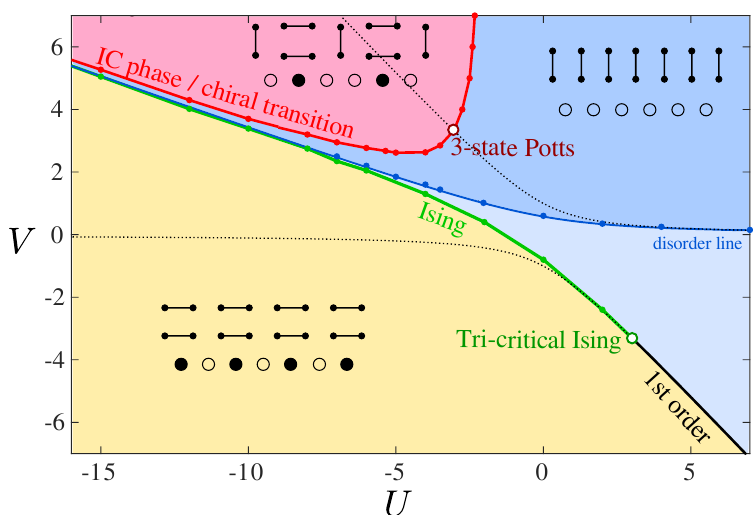
Figure 8: Combined phase diagram of the quantum dimer model defined by the Hamiltonian of Eq.10, and of the hard-boson model of Eq. 2 as a function of the nat- ural coupling constants of the hard-boson model U and V . It contains three gapped phases: the rung dimer phase, the columnar leg dimer phase, and the period-three phase. Sketches of the phases in both the QDM language (top) and hard-boson model (bottom) are included. The nature of the transition between the rung-dimer phase and the period-three phase changes along the critical line: (i) It is the three-state Potts universality class at the critical point (open dark red circle) on the integrable line (dotted line); (ii) In the vicinity of the integrable point the transition is chiral in the Huse-Fisher universality class [ 27 ] ; (iii) Far from the Potts point the transition is through an intermediate floating phase in the Luttinger liquid universality class. The width of the critical phase is smaller than the width of the red line. The transition between the columnar leg and rung dimer phases is continuous in the Ising univer- sality class (green line) above the tricritical Ising point (open green circle) and first order (thick black line) below